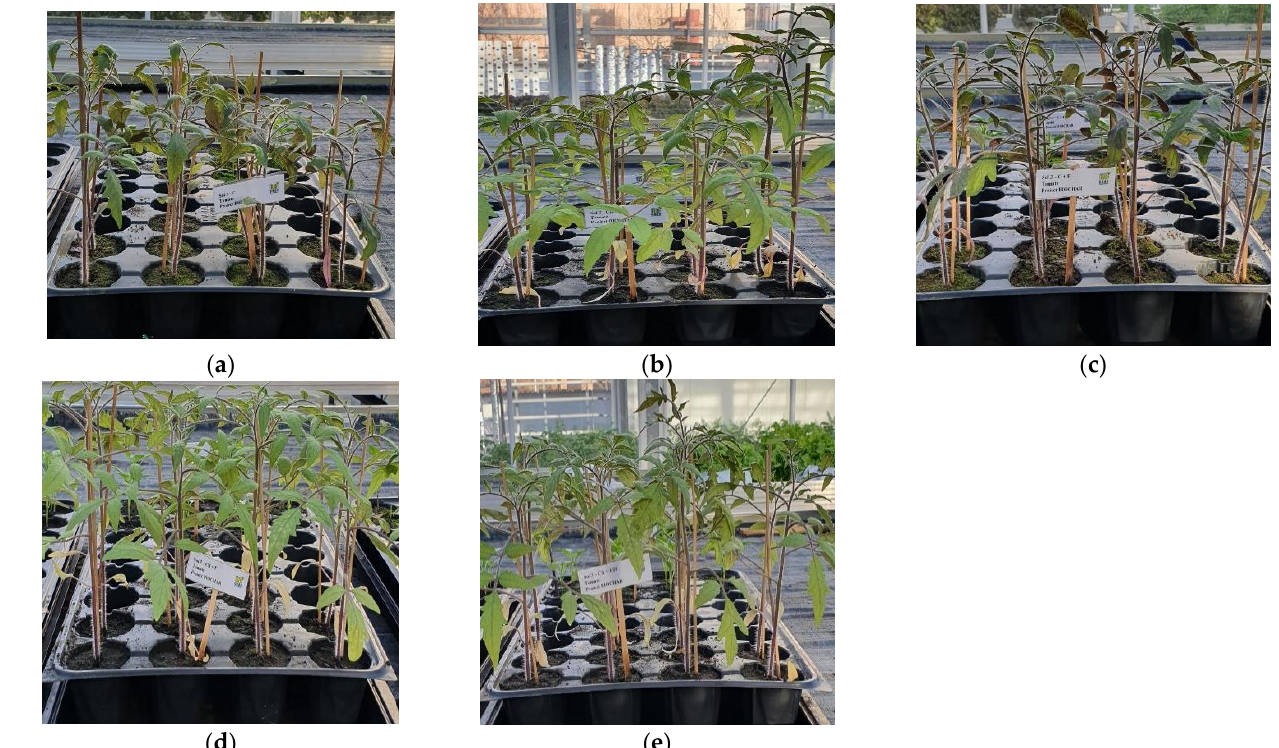
Figure 5. Images of tomato plants grown for 66 days in non-amended and BC-amended strongly acidic soil S3 (Luvisol) using the following treatments (10 plants per treatment): ( a ) S3; ( b ) S3 + BC; ( c ) S3 + F; ( d ) S3 + BC + F; ( e ) S3 + BC + F/2.